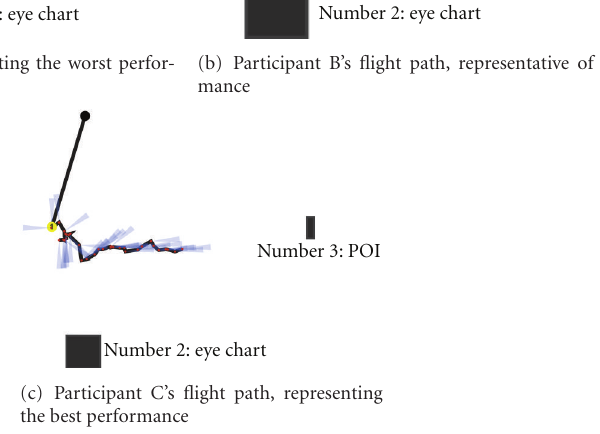
Figure 13: Examples of participant flight